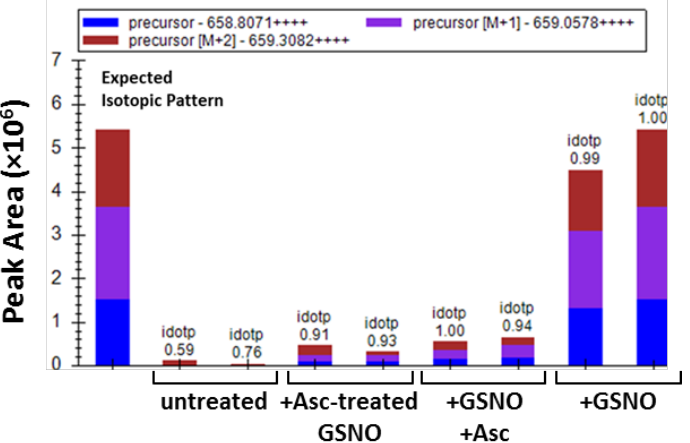
Figure 2. Identification of CSE exposed S -nitrosated cysteine(s) by mass spectrometry. Comparison of the peak areas corresponding to the tetra charged ion at m/z 658.81, which corresponds to the tryptic peptide 213 YMNGHSDVVMGLVSVNCESLHNR 235 with acrylamide (AA) incorporation at Cys229 in: GSNO-treated CSE (+GSNO); GSNO-treated CSE following incubation with ascorbate (+GSNO +Asc); GSNO pre-incubation with ascorbate before CSE treatment (+Asc-treated GSNO); untreated CSE (untreated). Two representative replicates of each sample are represented. The isotopic pattern ([M], [M + 1] and [M + 2] peaks) obtained is fully consistent with the one expected for the modified peptide. Idotp: dot product of the expected isotope